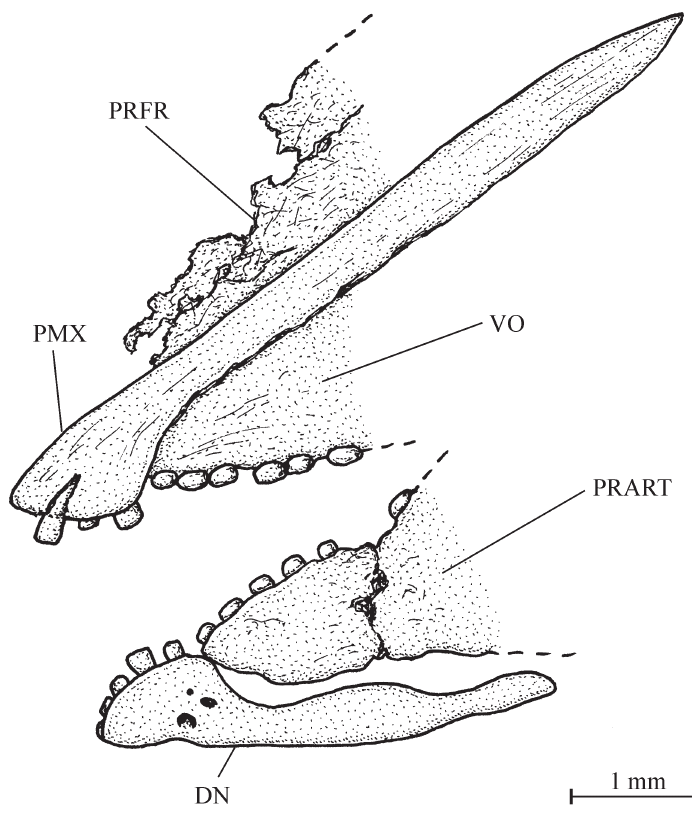
Fig. 11. Acrorhinichthys poyatoi gen. et sp. nov. Jaws of holotype CLC